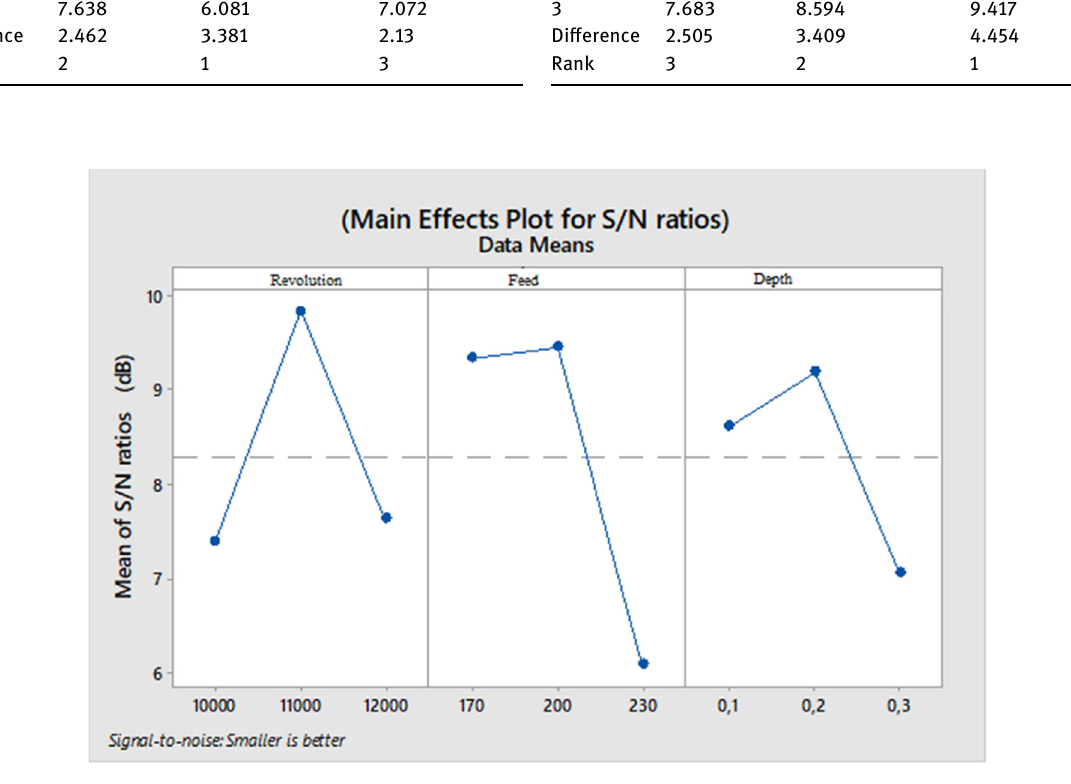
Figure 5: Main e ff ect plot ( 1.0 mm ) .